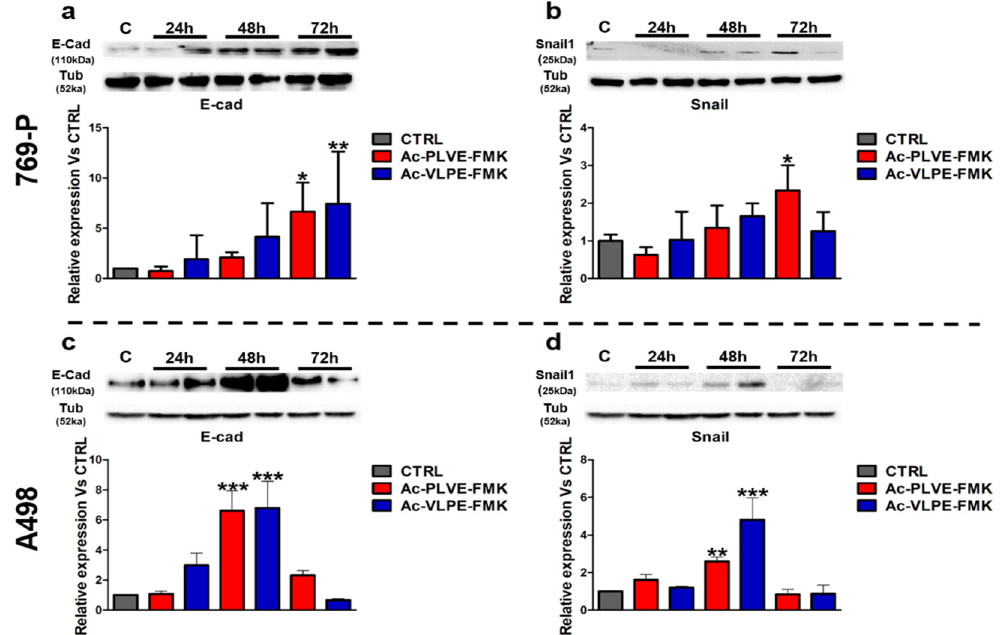
Figure 6. Effects of the peptides on E-cadherin and SNAIL1 protein expression: ( a , b ) protein expression of E-cadherin and SNAIL1 in 769-P and ( c , d ) A498 cells after 24, 48, and 72 h of treatment with the peptides. Data are represented as mean ± SD of at least three replicates. Significance was calculated through one-way ANOVA, followed by Dunnet’s test.